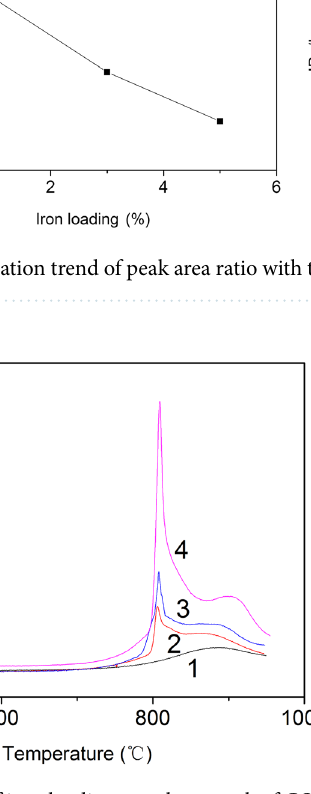
Figure 4. Effect of iron loading on release peak of CO. 1 Acid-washing coal char; 2 Coal char with 1% Fe; 3 Coal char with 3% Fe; 4 Coal char with 5%